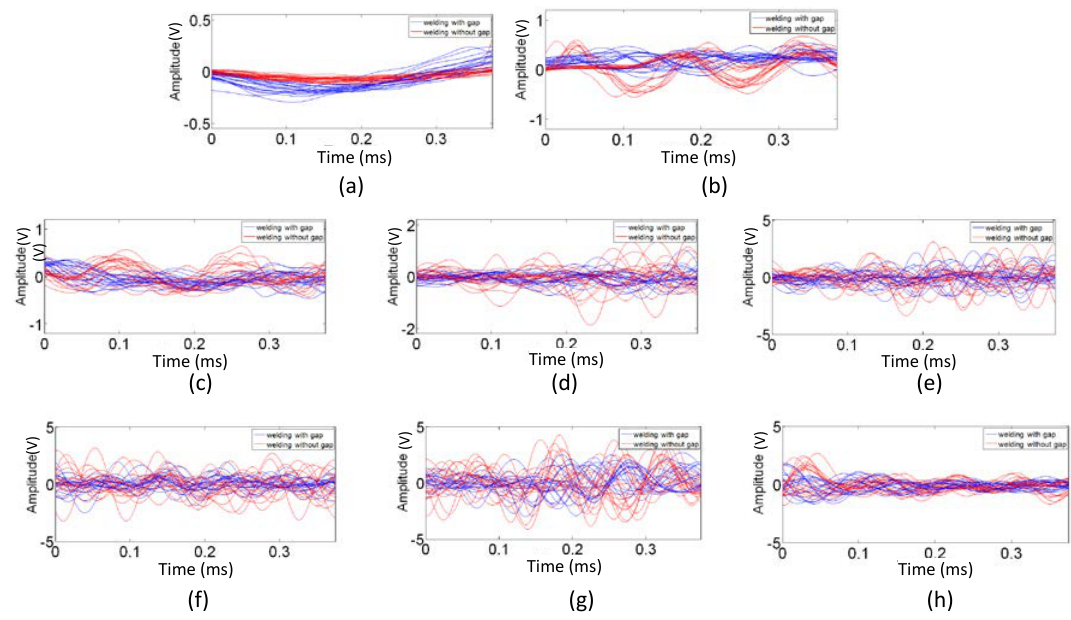
Figure 9. Time-domain sound signal for each selected section with high- and low-joint-bonding strengths (10 samples for each case): ( a ) first section; ( b ) second section; ( c ) third section; ( d ) fourth section; ( e ) fifth section; ( f ) sixth section; ( g ) seventh section; ( h ) eighth section.